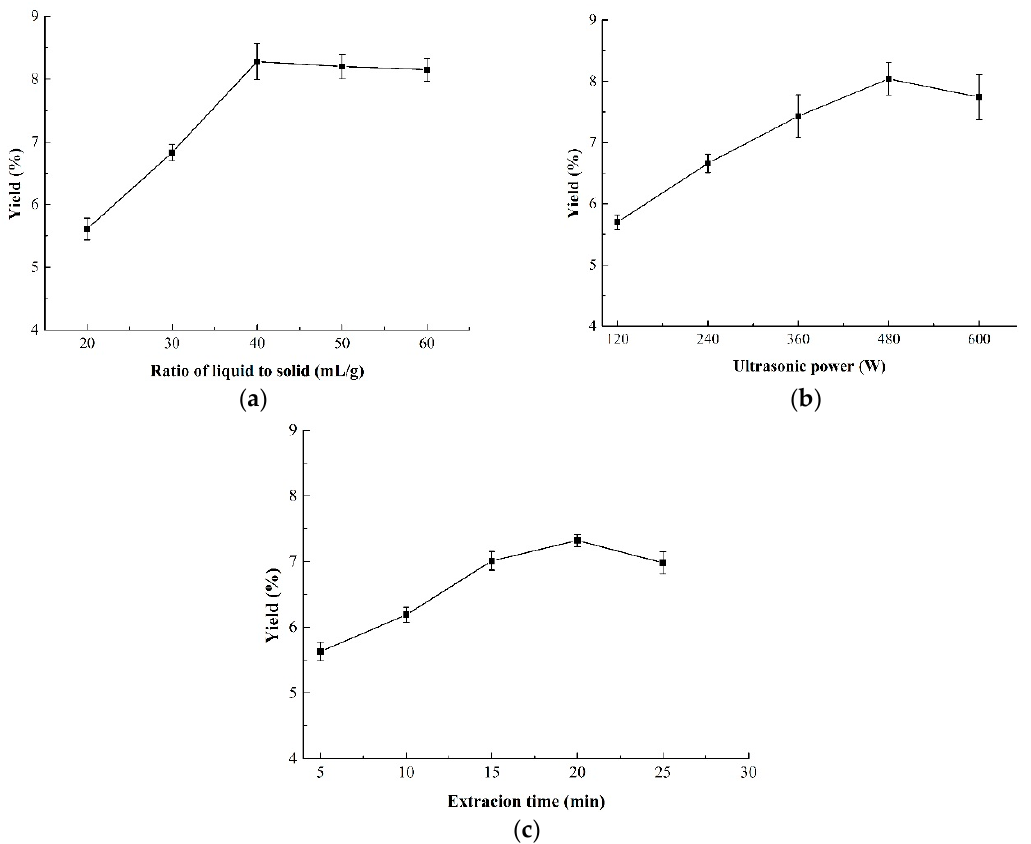
Figure 1. Effect of three independent variables on the yield of CMP-U. ( a ) Ratio of liquid-to-solid; ( b ) ultrasonic power; and ( c ) extraction time. CMP-U: C. morifolium polysaccharides obtained by ultrasonic assisted extraction.